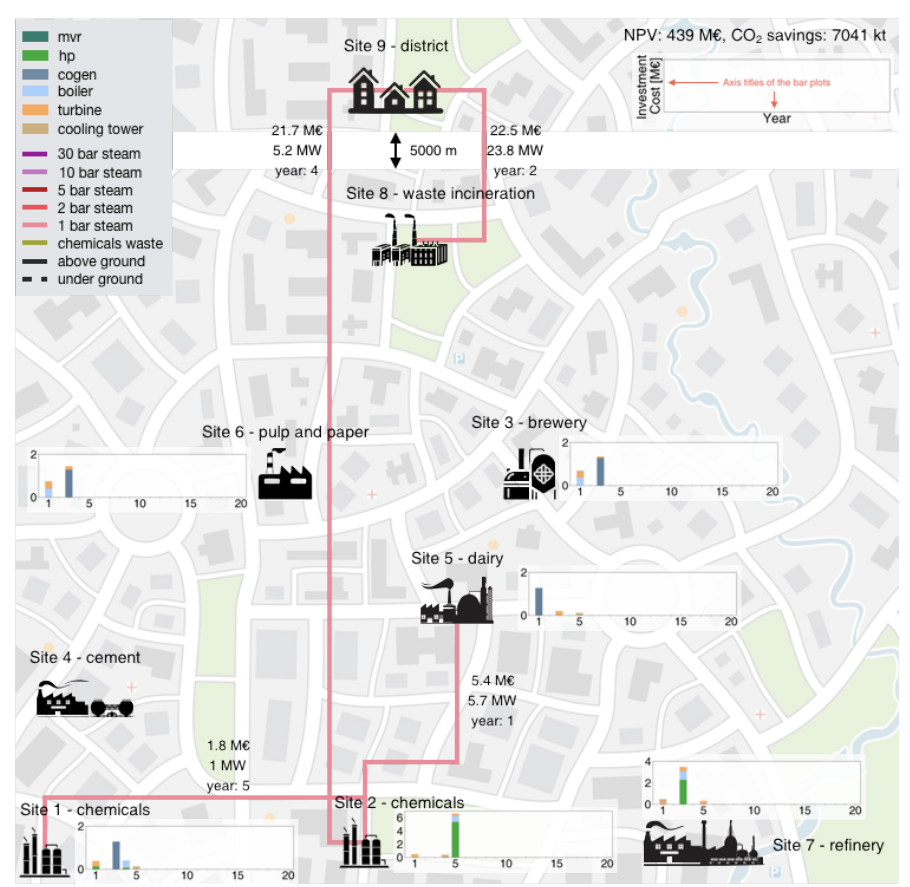
Figure 8. Optimal investment decisions with 5 years of investment and 16 M e annual